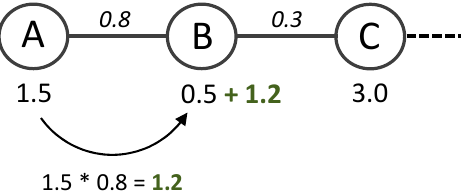
Figure A2. Example of expertise level update